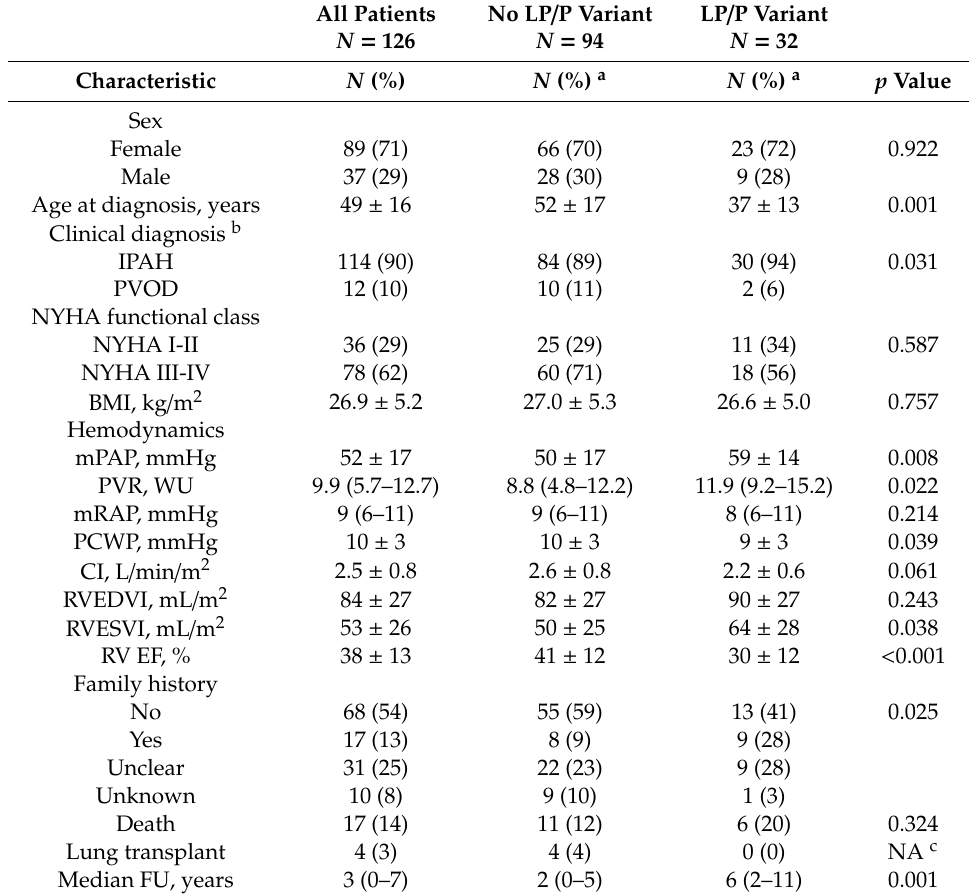
Table 1. Sociodemographic and clinical characteristics of patients eligible for genetic testing at diagnosis.